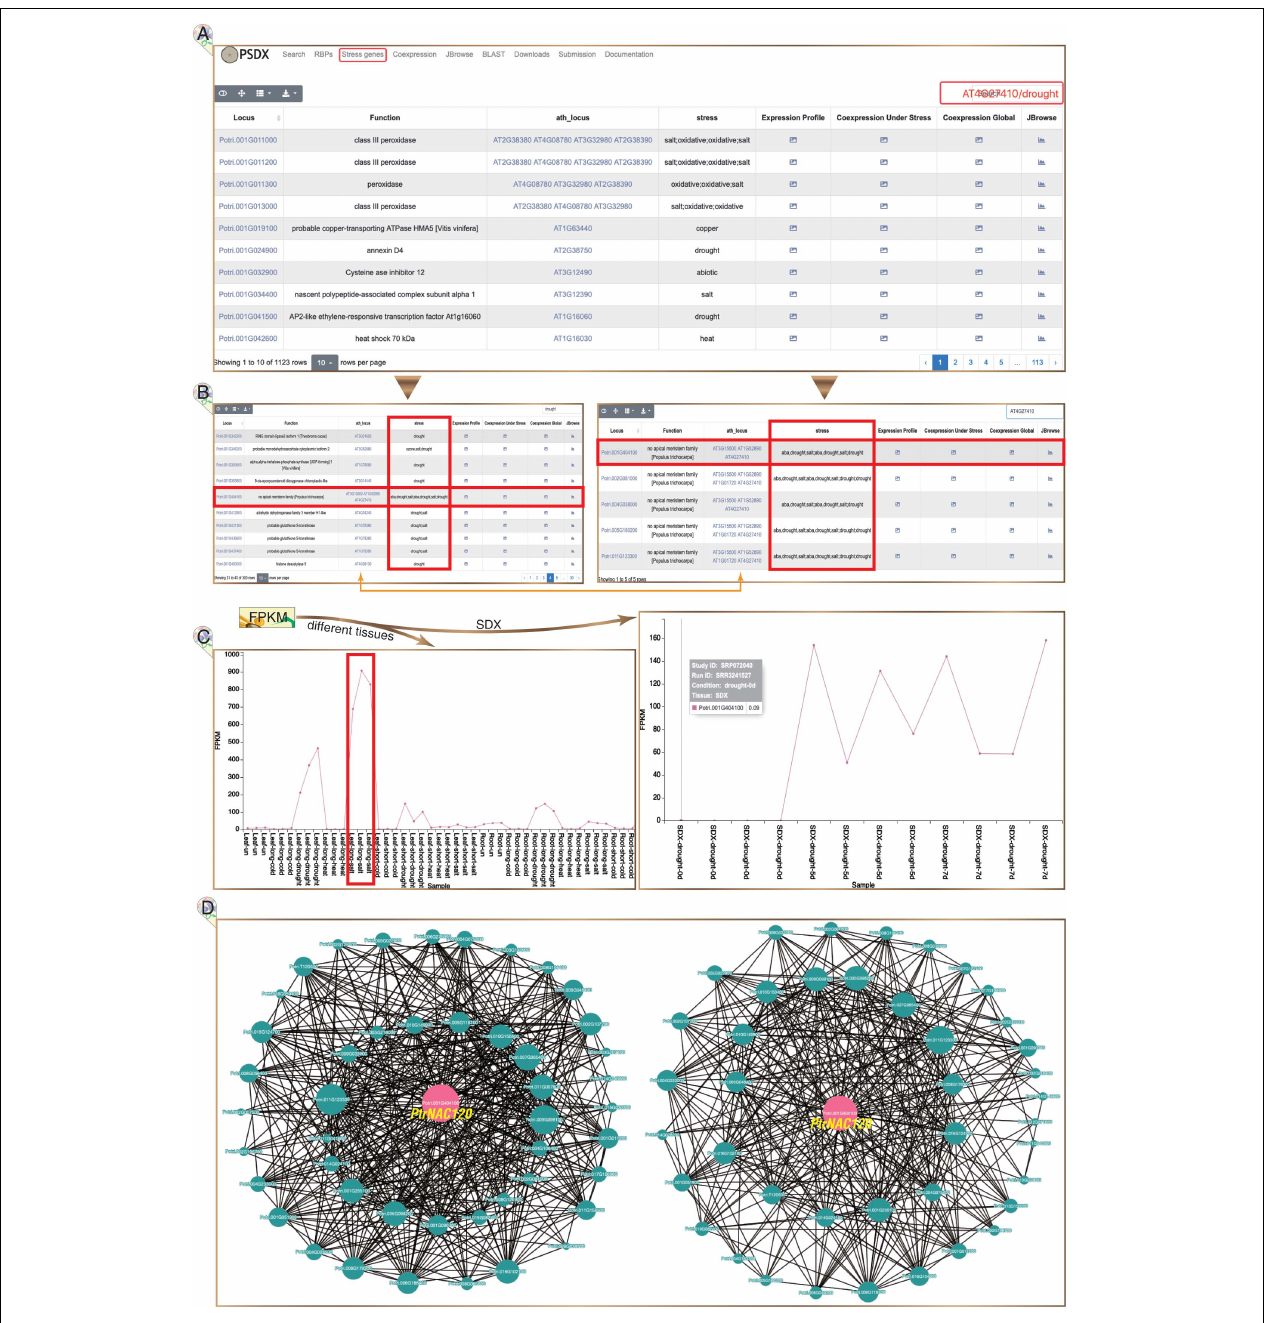
FIGURE 5 | Stress response genes in P. trichocarpa . (A) The module of stress response genes. (B) Following searches, all P. trichocarpa genes homologous to AT4G27410 (left panel) and all drought stress-responsive genes (right panel) are returned from a query. (C) Potri.001G404100 ( PtrNAC120 ) is up-regulated upon drought and salt stress, especially significantly up-regulated under salt stress in leaves (left panel). (D) Stress-responsive genes co-expression network is presented under stress treatment libraries (left panel) and all RNA-seq libraries (right panel), respectively.